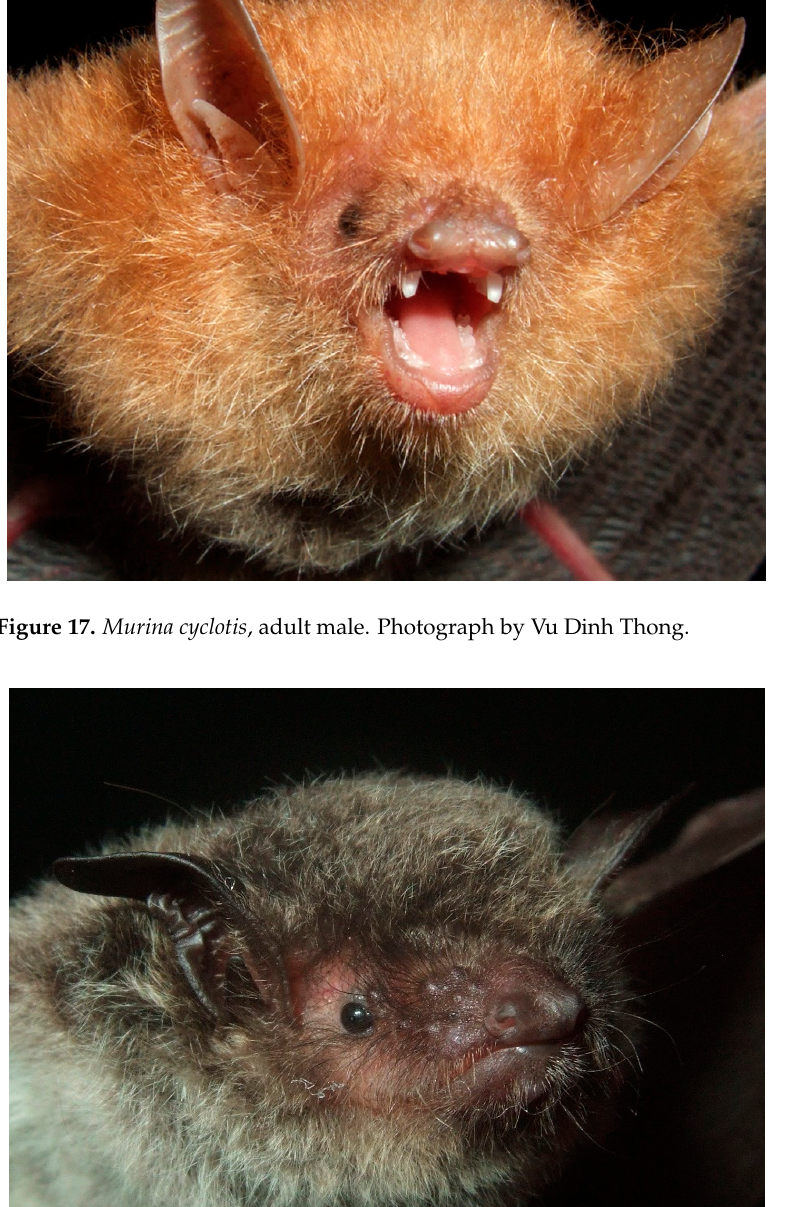
4.1.17. Myotis hasseltii